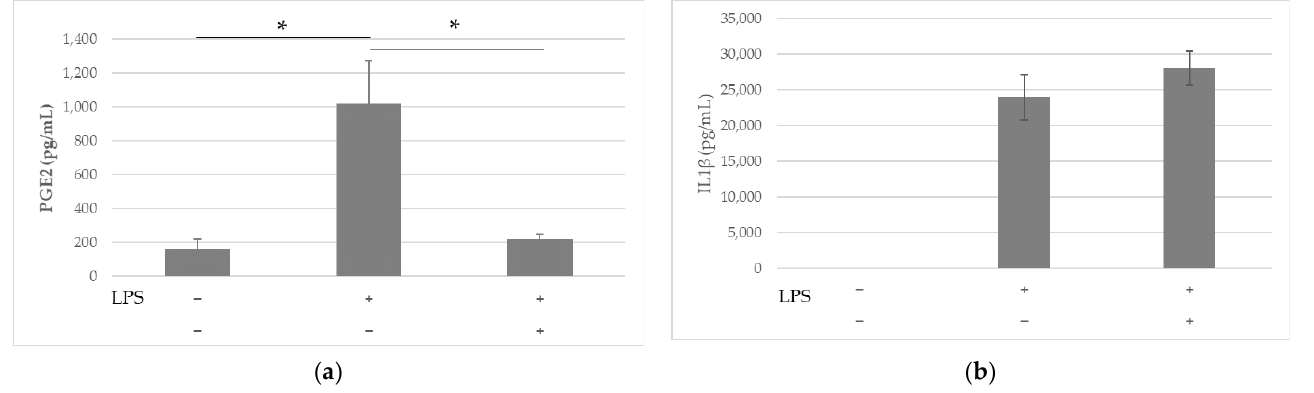
Figure 2. Concentration of ( a ) PGE2 and ( b ) IL1 β , in the supernatants of the PBMCs incubated with or without LPS (1 µg/mL) and with or without LS-E (50 µg/mL) for 24 h; results are presented as mean and standard error, n = 5, *: p ≤ 0.05.